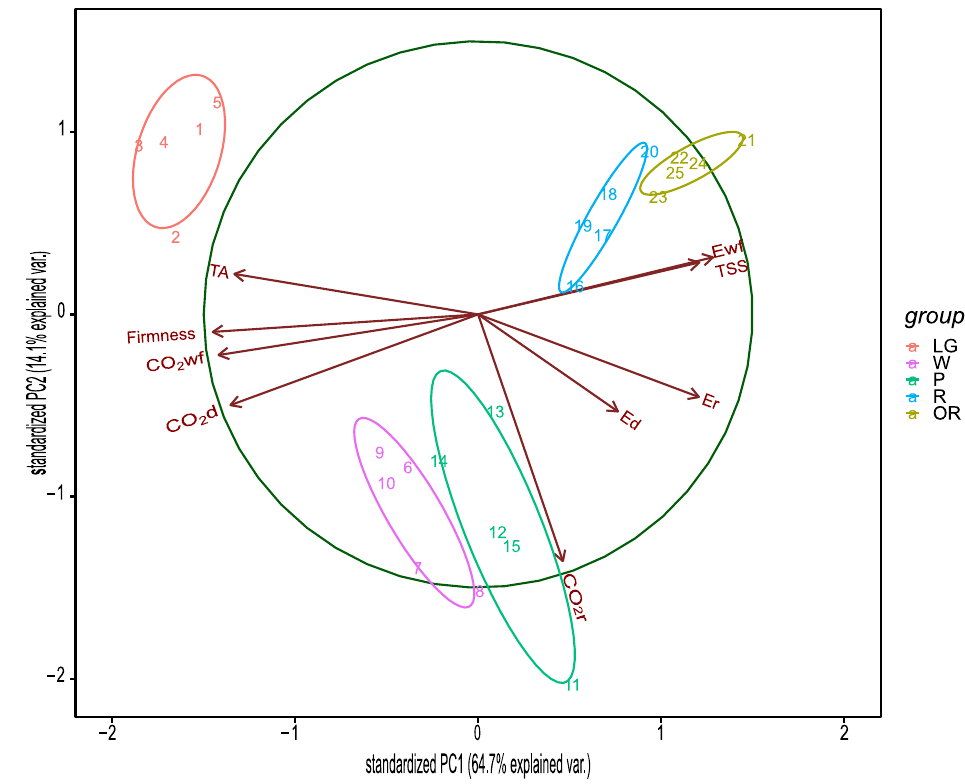
Figure 4. The principal component analysis (PCA) biplot for physiological and quality indices of raspberry ( Rubus idaeus ‘Heritage’) fruit during development. The fruit was harvested and sorted by size and color as follows: large green (LG), white (W), pink (P), red (R) and overripe (OR) fruit. Ewf: ethylene production in whole fruit; Ed: ethylene production in drupelets; Er: ethylene production in the receptacle; CO 2 wf: ethylene production in whole fruit; CO 2 d: ethylene production in drupelets; CO 2 r: ethylene production in the receptacle; TSS: total soluble solids content; and TA: titratable acidity.